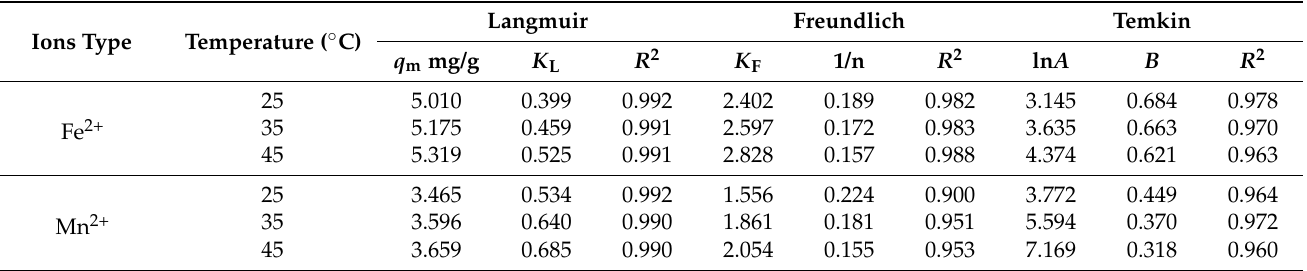
Table 1. Fitting results of the isothermal model for IHA/TM adsorption of iron and